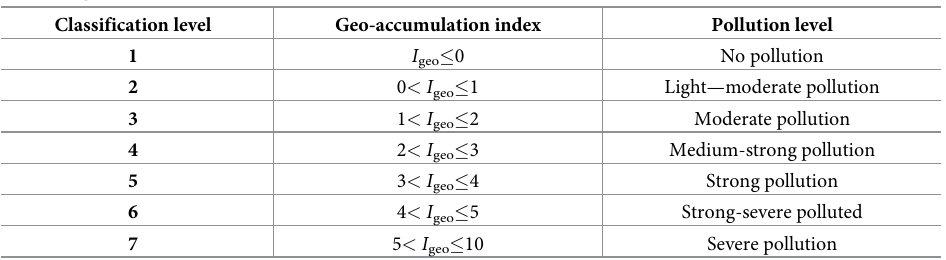
Table 2. I geo classification standards.